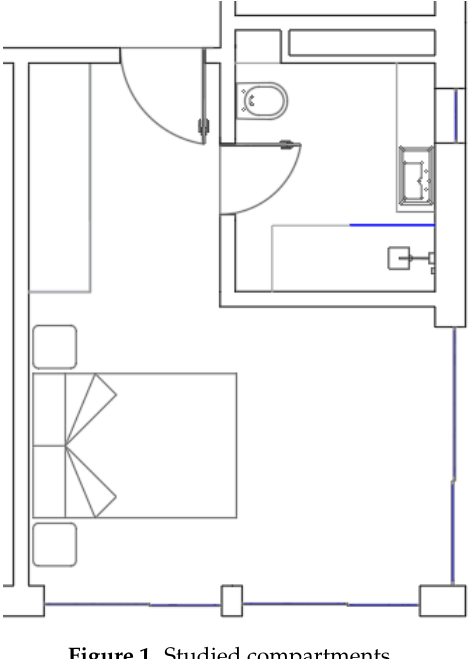
Figure 1. Studied compartments. Table 3. Characteristics of the two compartments.